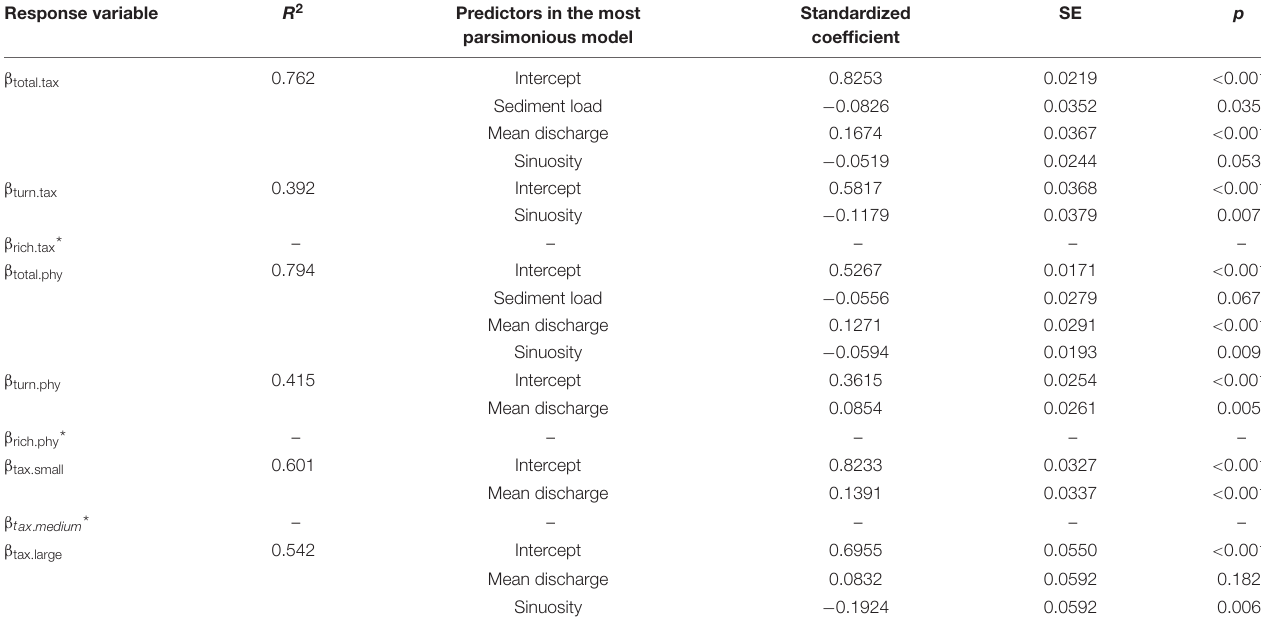
TABLE 3 | Results of the multiple regression